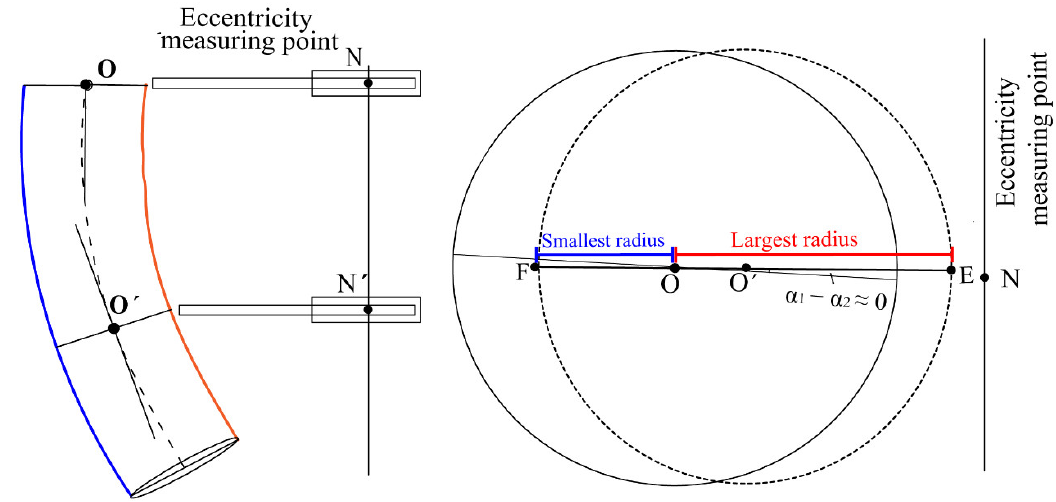
Figure 3. Projection of circle O′ on the plane of circle O.